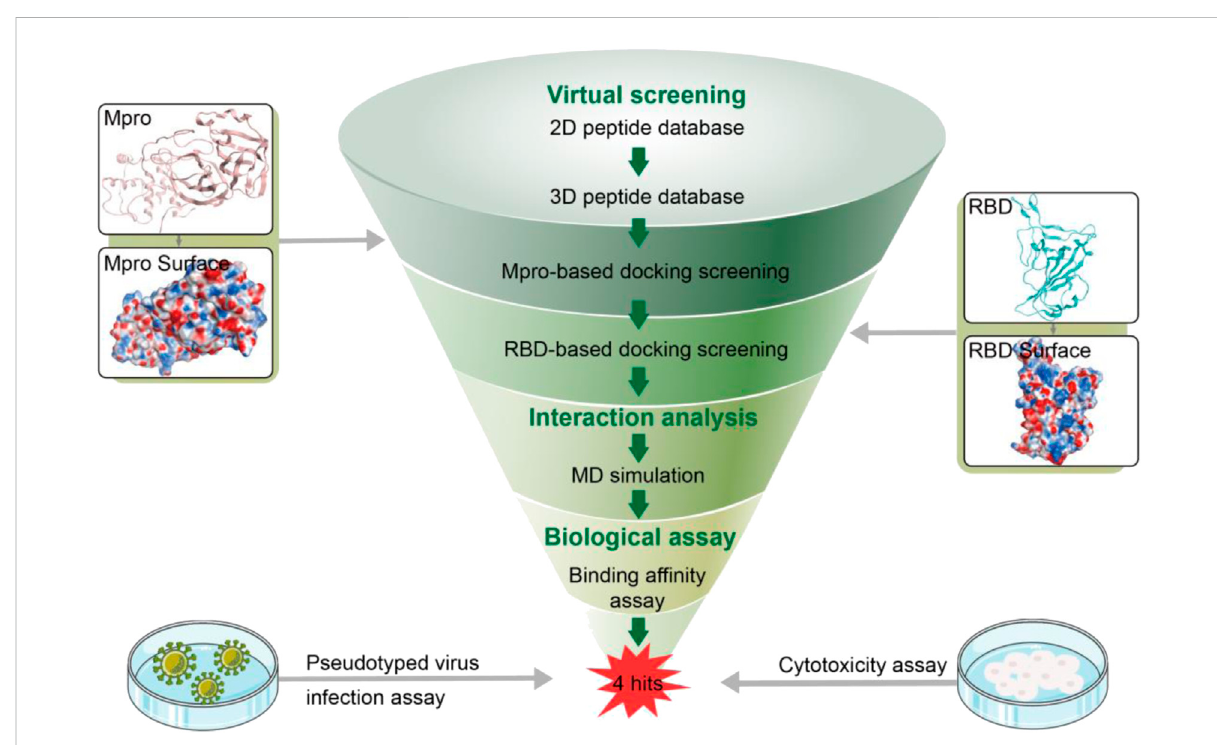
FIGURE 2 Work fl ow of the combinatorial screening process of dual RBD/Mpro-targeting